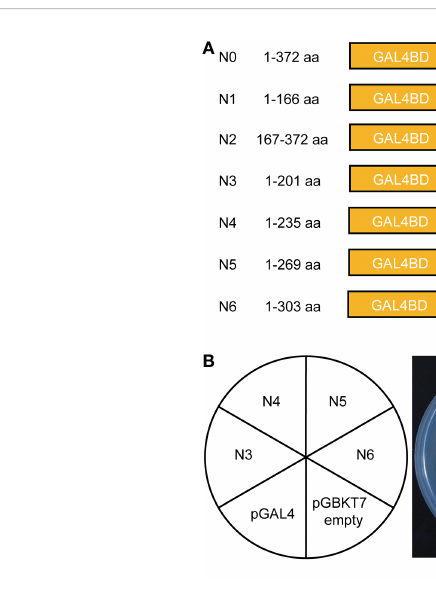
FIGURE 4 Transactivation activity assay of full-length and truncated IbNAC43 in yeast. (A) Schematic diagrams representing the IbNAC43 fragments encoding different parts of IbNAC43 that were cloned into the pGBKT7 vector. (B) Different fusion constructs were introduced into the yeast strain AH109 and examined on SD/-Trp and SD/-Trp/-His/X- a -Gal selection media. The pGBKT7 empty vector and pGAL4 were used as negative and positive controls, respectively. Scale bar , 1